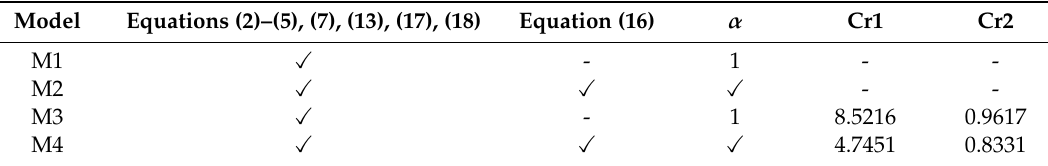
Table 1. Iterative calculation procedure for the